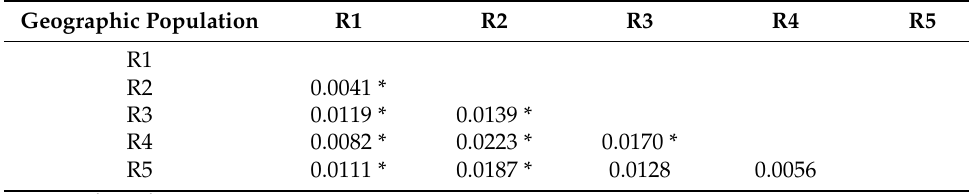
Table 4. Genetic distances between the five geographic populations sampled. Geographic Population